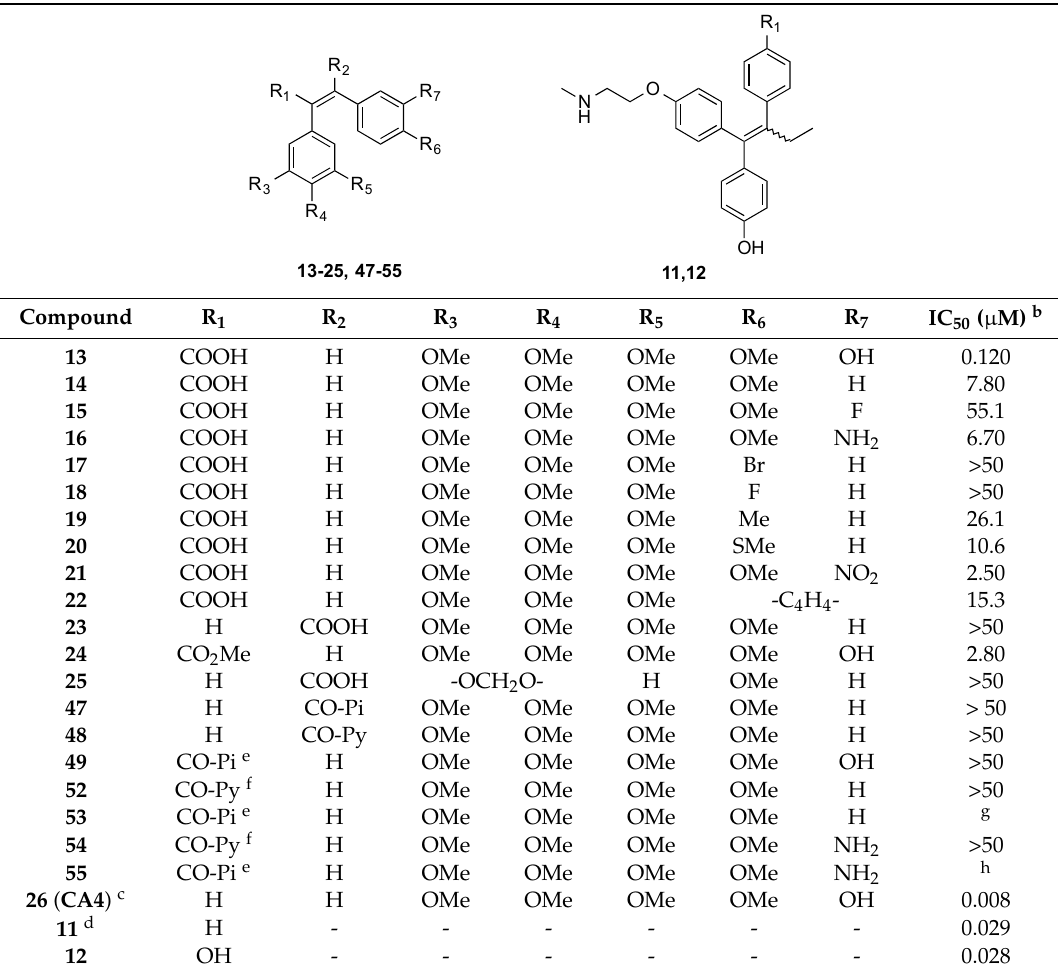
Table 1. Antiproliferative effects of acrylic acids 13 – 25 in MCF-7 human breast cancer cells a .